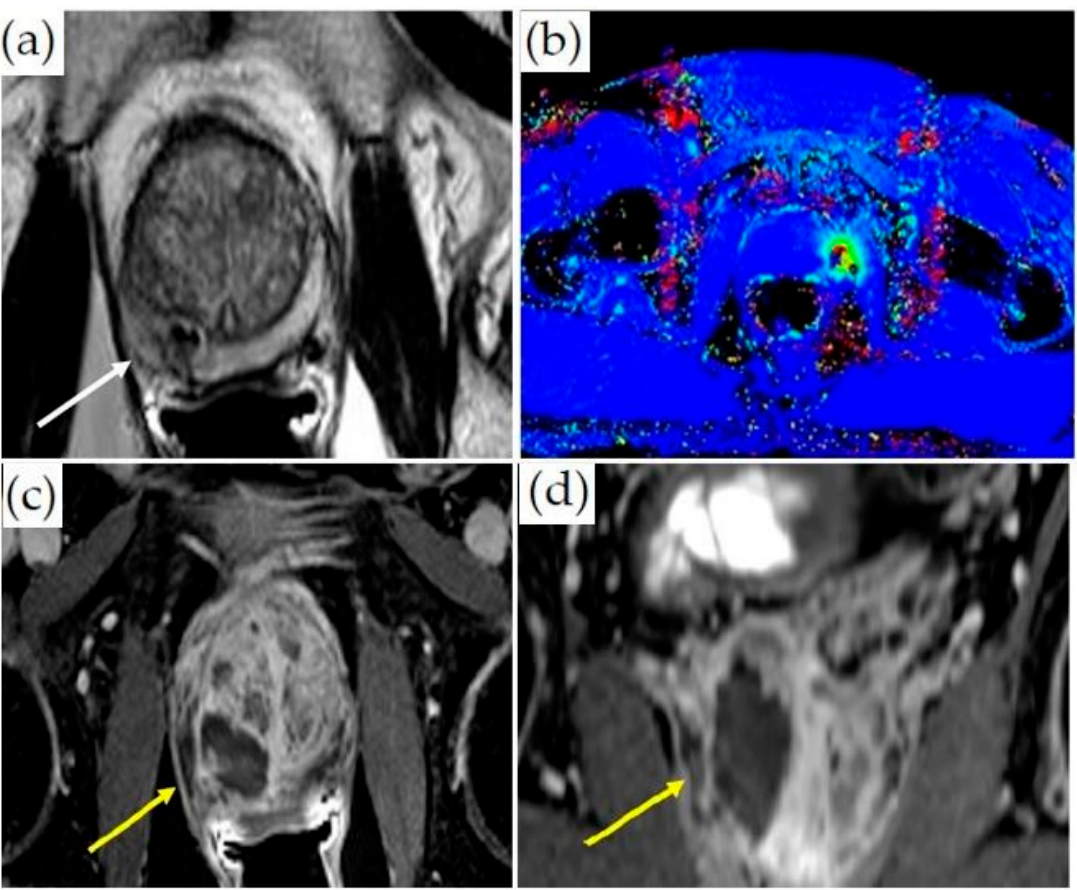
Figure 5. MRI-guided laser ablation: ( a ) Axial T2-weighted MR images with lesion in the right medial peripheral zone (white arrow). ( b ) Thermometry mapping (different patient) during treatment. ( c ) Axial and ( d ) coronal post-contrast T1-weighted imaging demonstrating ablation cavity (yellow arrows).